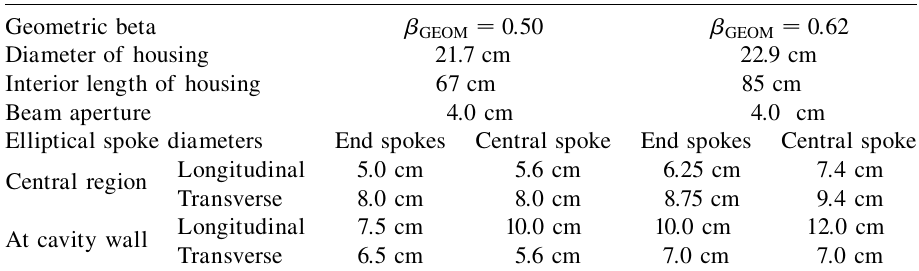
TABLE I. Geometric parameters of the two types of triple-spoke cavities. The radius of the spherical end walls is 40 cm, and all blend radii are 1.27